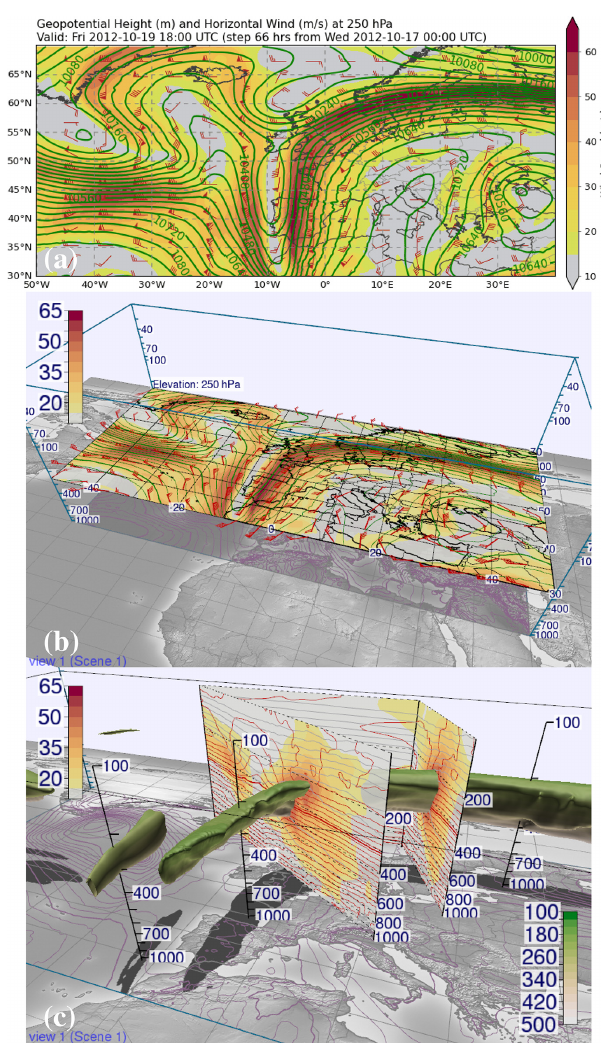
Figure 3. Bridge from 2-D to 3-D visualization. (a) Horizontal section of geopotential height (contour lines) and horizontal wind speed (colour) at 250hPa, as obtained from the DLR Mission Support System. ECMWF deterministic forecast from 00:00UTC, 17 October 2012, valid at 18:00UTC, 19 October 2012. (b) The same data, rendered by Met.3D and mapped into the 3-D context. The section can be interactively moved by the user. (c) Vertical section of horizontal wind speed (colour) and potential tempera- ture (contour lines) in Met.3D, amended by a 50ms − 1 isosurface of wind speed, coloured by pressure (hPa). Note how spatial per- ception of the 3-D isosurface is aided by rendering shadows and labelled vertical poles (animated version of this figure in the Sup- plement at